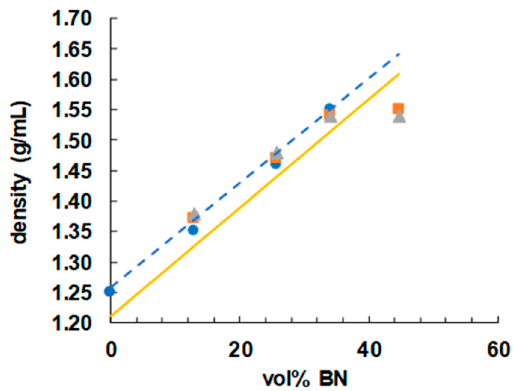
Figure 10. Density as a function of vol % BN for epoxy-thiol samples with different BN platelet sizes: 2 µm, blue circles; 30 µm, orange squares; 180 µm, grey triangles.